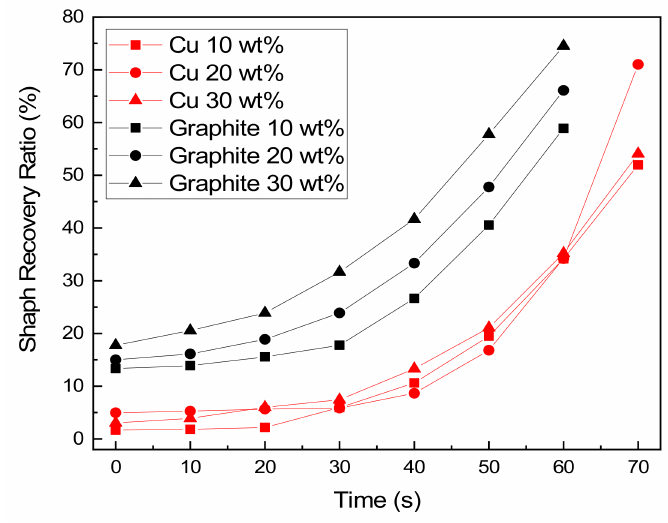
Figure 10. Shape recovery rate by type of filler and amount. Table 5. Shape recovery rate at 60 s of experiment.